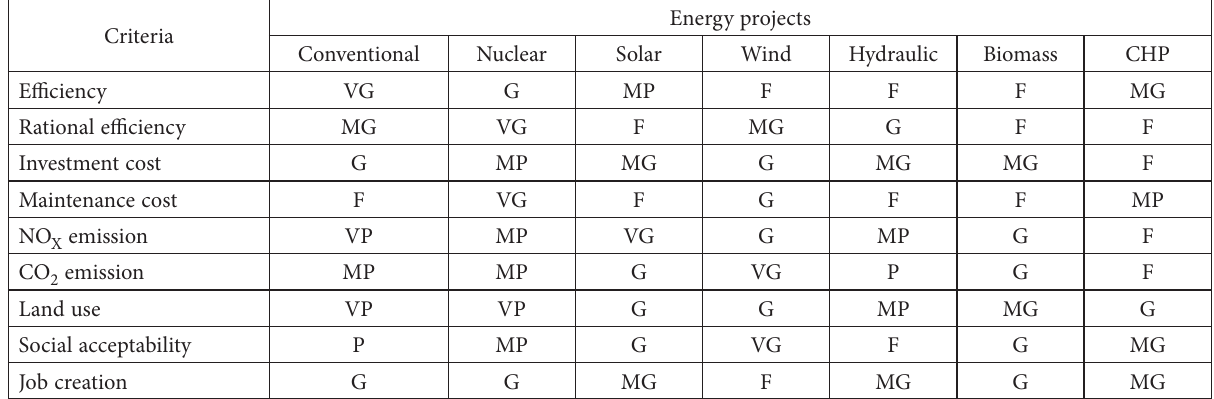
Table 3. Judgment matrix of DM2